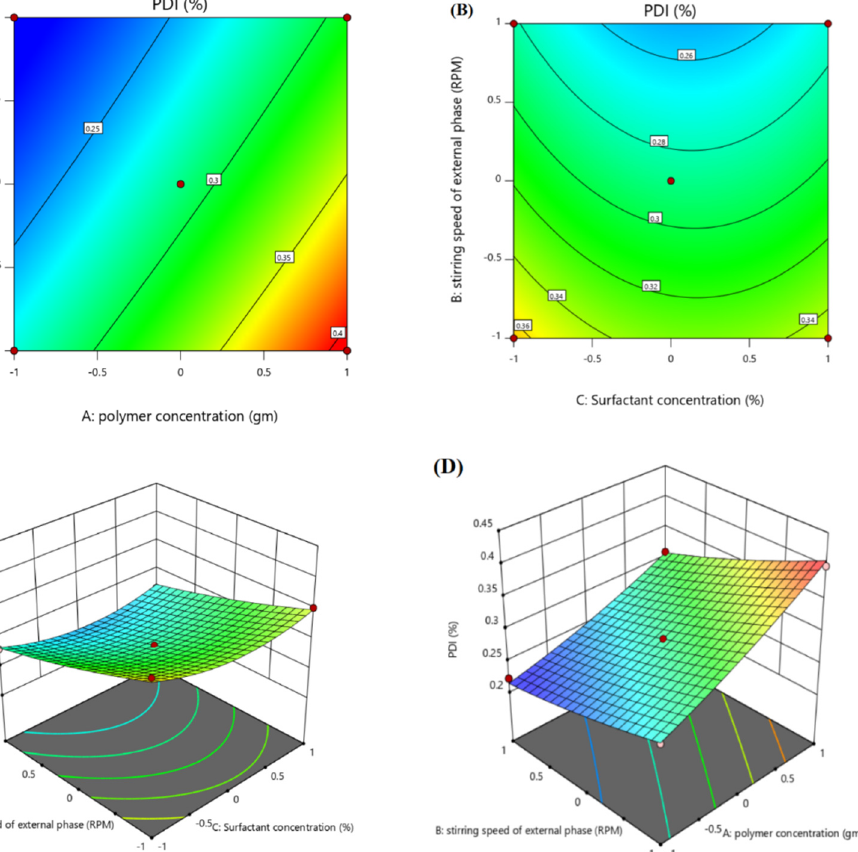
Figure 3. Contour surface plots showing the effect of independent variables (factors) on the poly- dispersity index (Y2) of the optimized ACR-PCL-NPs. ( A ) Impact of polymer concentration and stirring speed on PDI, ( B ) impact of stirring speed and surfactant concentration on PDI and 3D plots, ( C ) impact of stirring speed and surfactant concentration on the PDI, ( D ) impact of polymer concen- tration and stirring speed on the PDI.